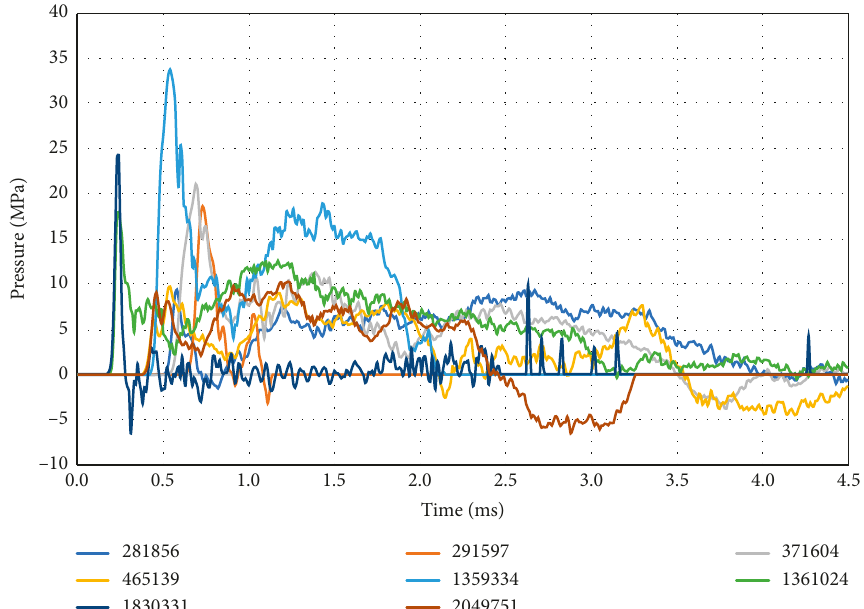
Figure 9: Pressure histories corresponding to the segments of the mining face modelled in the local